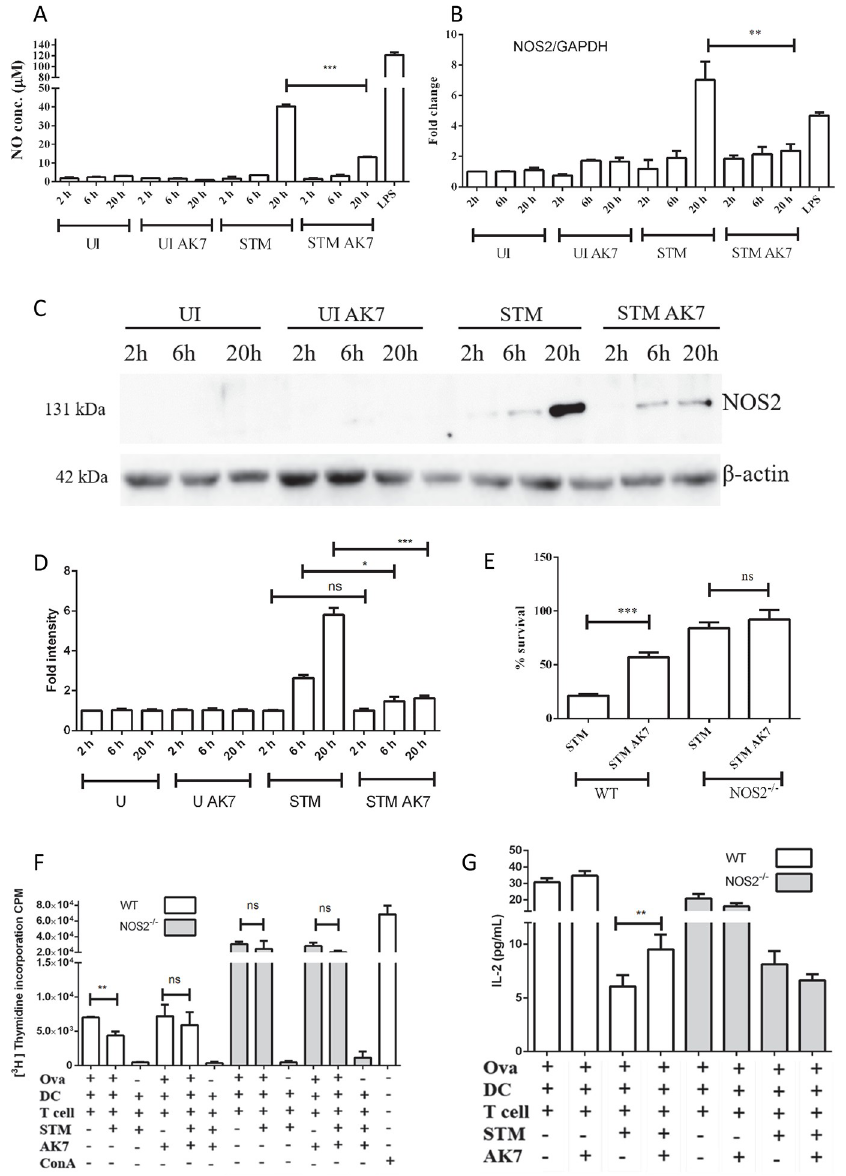
Fig 3. Effect of SIRT2 inhibition is nitric oxide mediated. A. Nitric oxide levels in conditioned media in response to SIRT2 inhibition at indicated time post infection. (UI- uninfected DCs, UI AK7- Uninfected DCs treated with 10 μ M AK7, STM- Salmonella Typhimurium infected DCs, STM AK7- - Salmonella Typhimurium infected DCs treated with 10 μ M AK7) (Data are presented as mean ± SEM of 5 independent experiments). B. qPCR analysis of NOS2 expression in DCs at indicated time post infection in response to SIRT2 inhibition. GAPDH was used as an internal control. (UI- uninfected DCs, UI AK7- Uninfected DCs treated with 10 μ M AK7, STM- Salmonella Typhimurium infected DCs, STM AK7- Salmonella Typhimurium infected DCs treated with 10 μ M AK7, LPS- 100 ng/ml LPS treated). (Data are presented as mean ± SEM of 3 independent experiments). C. Representative immunoblot of NOS2 in the presence and absence of SIRT2 inhibition at indicated time. (UI- uninfected DCs, UI AK7- Uninfected DCs treated with 10 μ M AK7, STM- Salmonella Typhimurium infected DCs, STM AK7- Salmonella Typhimurium infected DCs treated with 10 μ M AK7) D. Densitometry analysis of NOS2 level in the presence and absence of SIRT2 inhibition at indicated time. (UI- uninfected DCs, UI AK7- Uninfected DCs treated with 10 μ M AK7, STM- Salmonella Typhimurium infected DCs, STM AK7- Salmonella Typhimurium infected DCs treated with 10 μ M AK7) (Data are presented as mean ± SEM of 3 independent experiments). E. Percentage survival of intracellular Salmonella in DCs in gentamicin protection assay in the presence and absence of SIRT2 inhibitor in wild type and NOS2 -/- DCs. (Mock- DMSO treated, AK7- 10 μ M AK7 treated). (Data are presented as mean ± SEM of 4 independent experiments) F. 3 [H] Thymidine incorporation assay to assess CD8 + T cells proliferation during Salmonella infection in wild type and NOS2 -/- DCs in